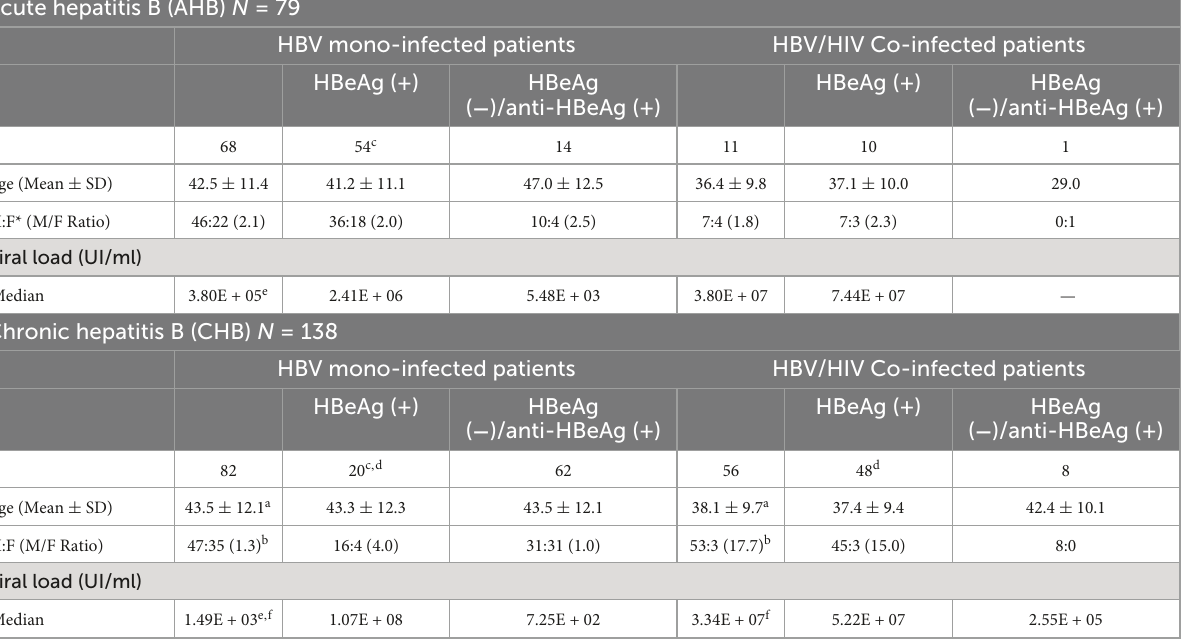
TABLE 1 Age, gender and hepatitis B virus (HBV) viral load distribution among different stages of HBV infection in mono and HBV/HIV co-infected patients. Acute hepatitis B (AHB) N = 79